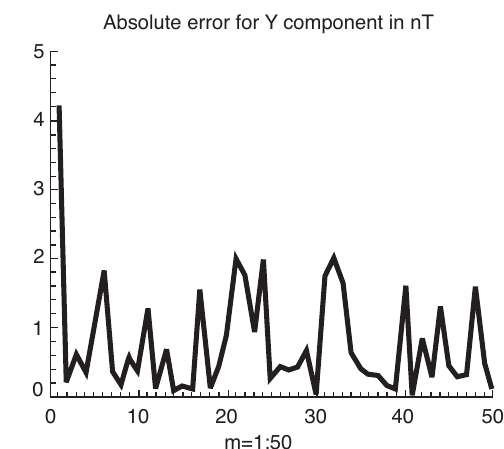
Fig. 1. Relative error of prediction of X-component for three different networks